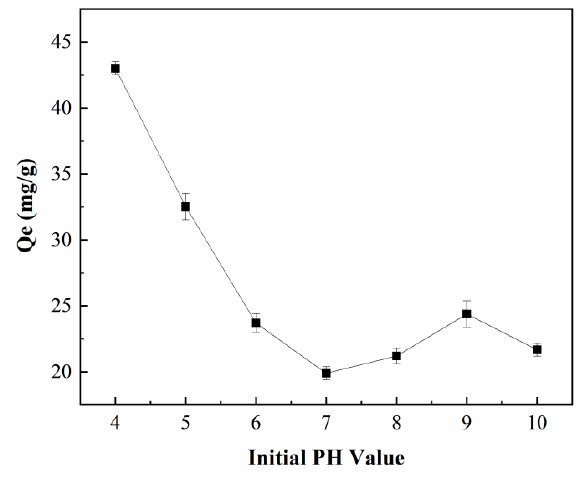
Figure 5. The effect of water pH on Cr (VI) adsorption by TMBC.